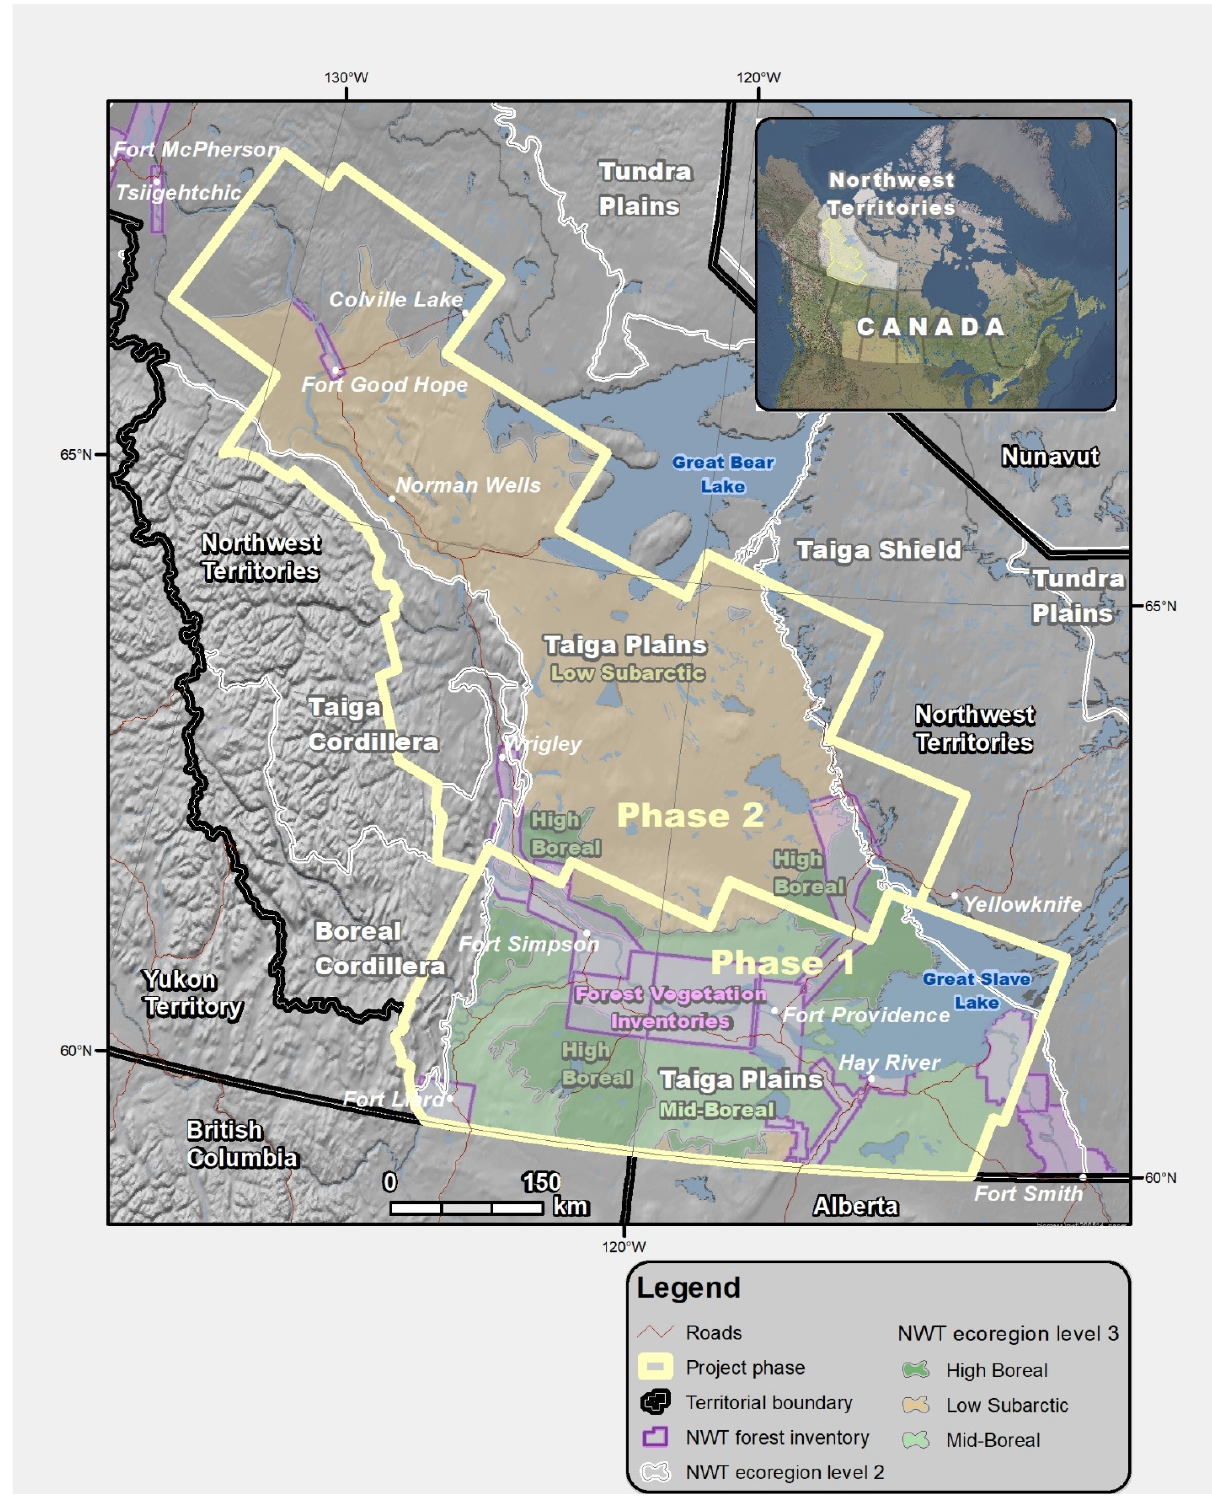
Figure 1. Overview of the Multisource Vegetation Inventory (MVI) project area. The ~151,700 km 2 Phase 1 has 2007 as the reference year, covers mostly the Taiga Plains Mid-Boreal (light green) and HighBoreal (dark green) ecoregions, and overlaps with ~36,600 km 2 of Government of the Northwest Territories (GNWT) Forest Vegetation Inventories (FVIs, purple polygons). The 244,000 km 2 Phase 2 has 2010 as the reference year, covers mostly the Taiga Plains Low Subarctic Ecoregion (brown), and overlaps with ~9500 km 2 of GNWT FVIs. Main populated places are shown as white dots.